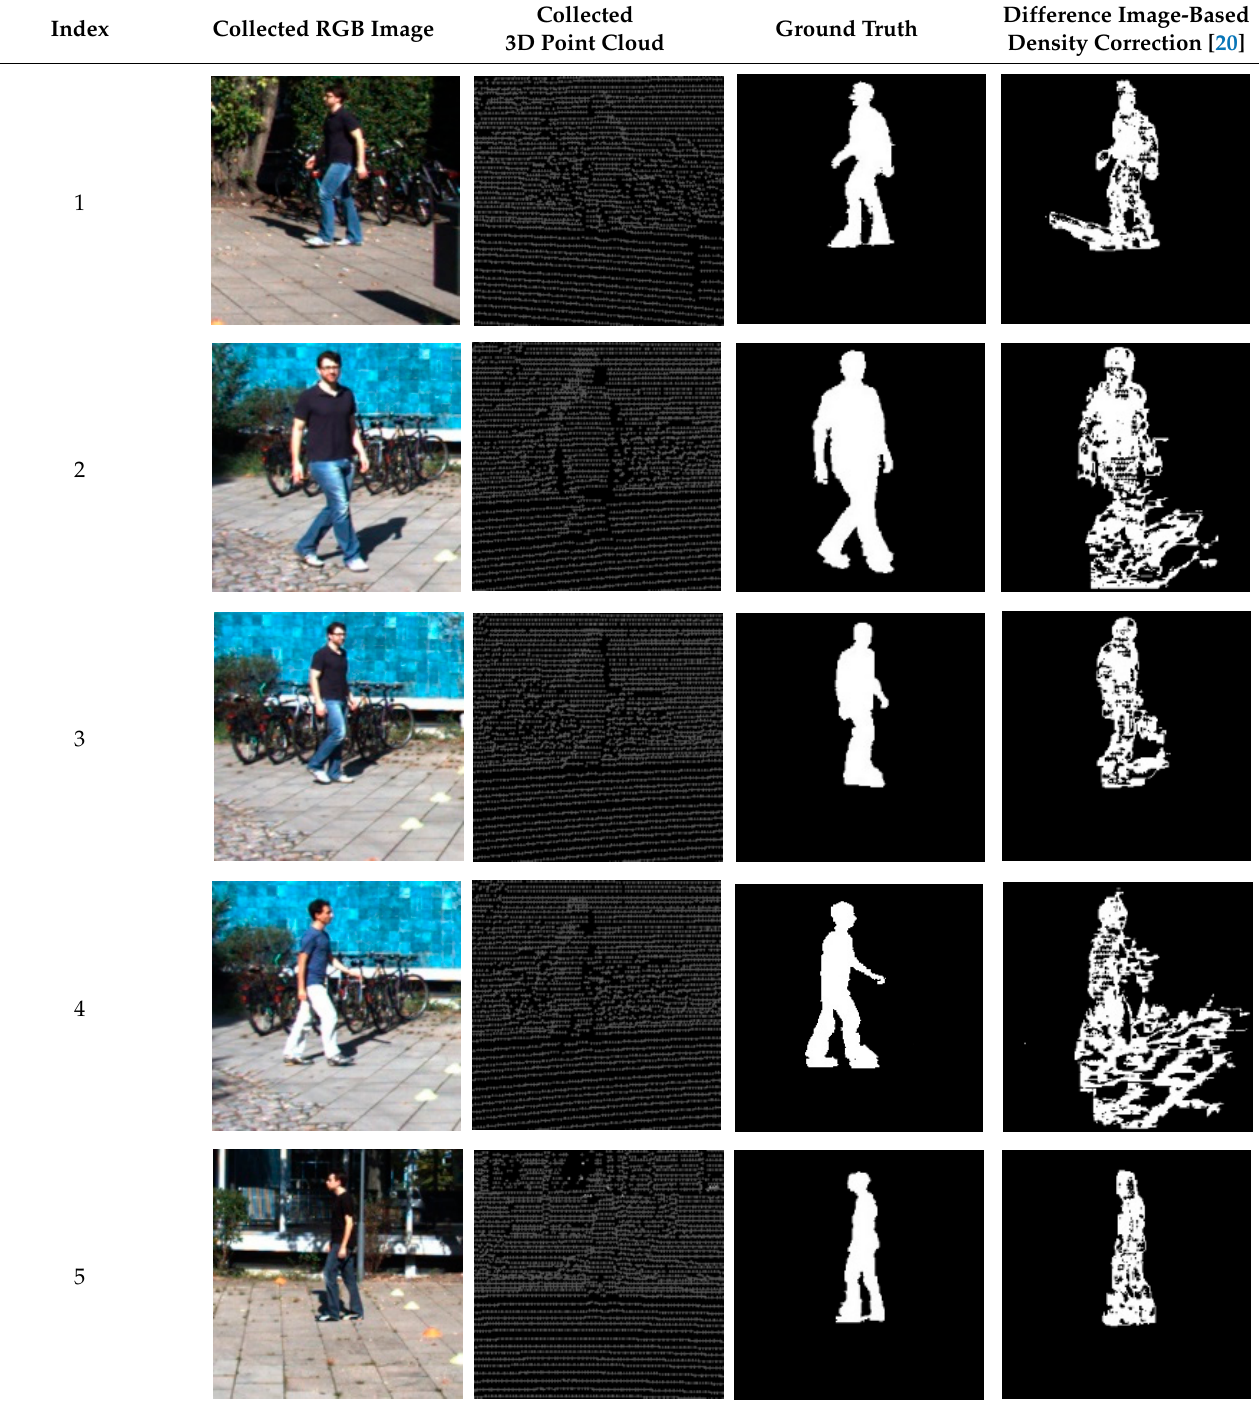
Table 4. Dense segmentation image result of each method.